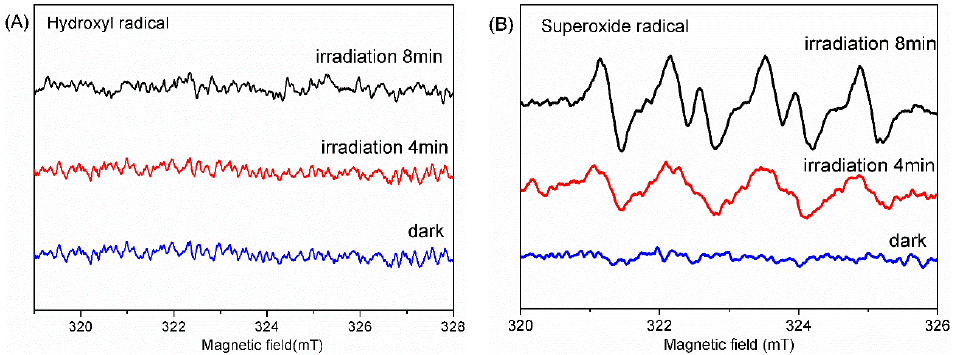
Figure 10. ESR spectra of AFO ‐ 6 ( λ > 420 nm): DMPO ‐∙ OH in water ( A ) and DMPO ‐∙ O 2 − in methanol ( B ).